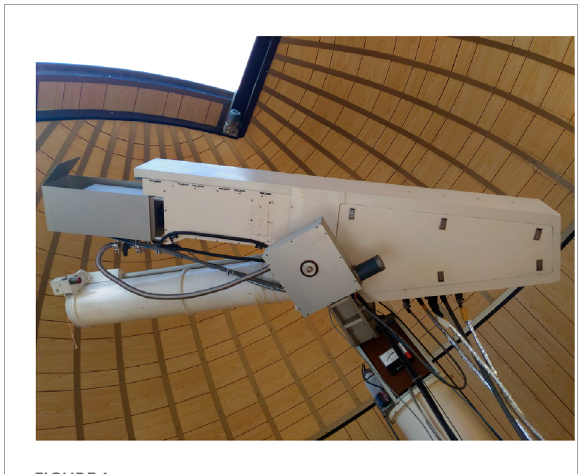
FIGURE 1 The Rome/PSPT telescope in the host-dome at the INAF Osservatorio Astronomico di Roma in Monte Porzio Catone (Rome, Italy). The telescope has an equatorial mount and body comprising a lower tube that includes the objective lens and its dust cover, and upper part with the secondary optics and appended recording device. The guiding system is located in the back part of the